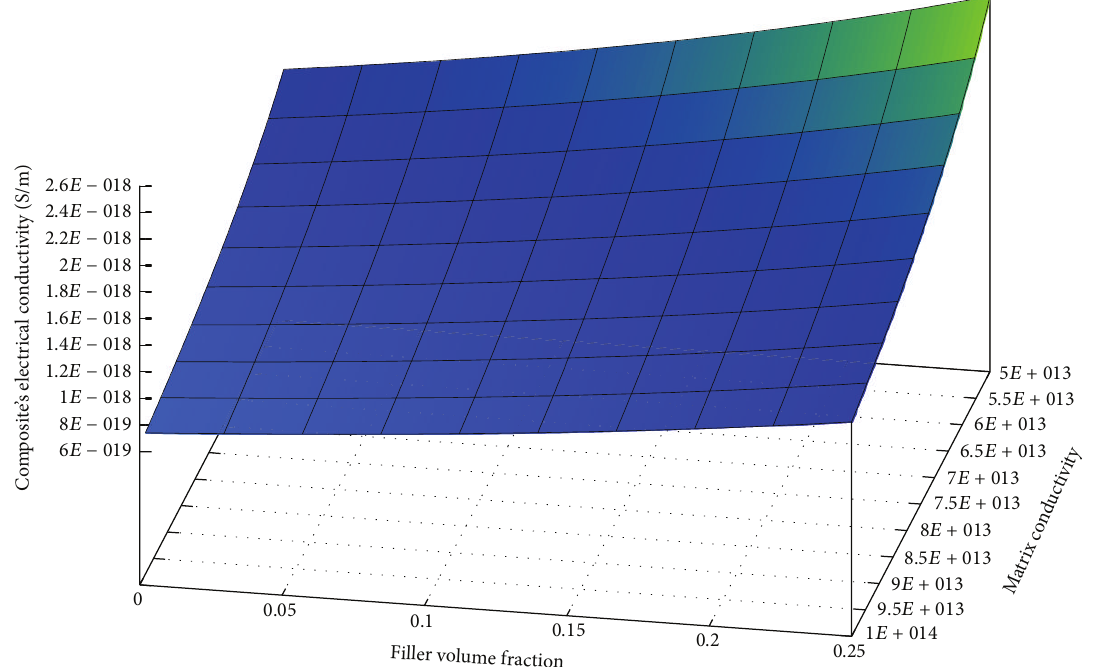
Figure 14: DC electrical conductivity of the nanocomposite when both conductivity of the matrix and the volume fraction of the filler are varied (McLachlan’s